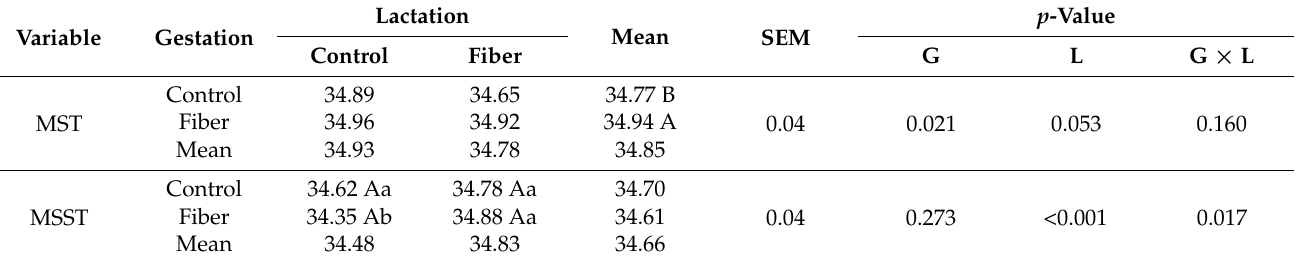
Table 7. Body surface temperature (MST) and mammary system surface temperature (MSST); tem- perature means ( ◦ C) of lactating sows with or without supplementation of dietary fiber in the